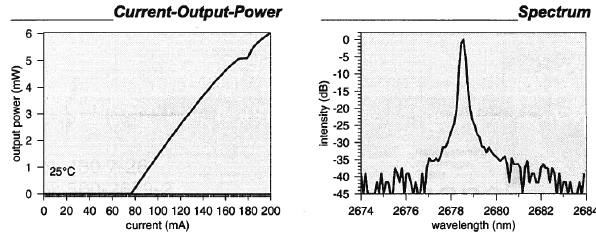
Fig. 3. DFB diode laser characteristics and spectrum.